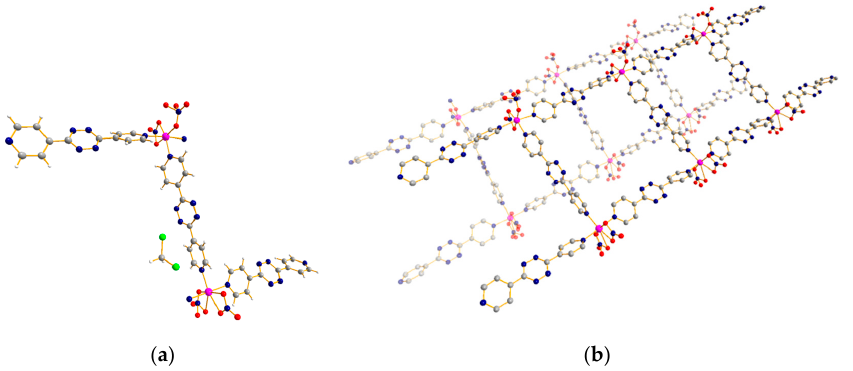
Figure 3. ( a ) Unit Structure of [Co 2 (pytz) 3 (NO 3 ) 4 ]· n DCM ( n = 4–6); ( b ) 1D ladder structure; Co ( magenta ), C ( grey ), H ( white ), N ( blue ), O ( red ). DCM and ligand H atoms omitted for clarity in ( b ).